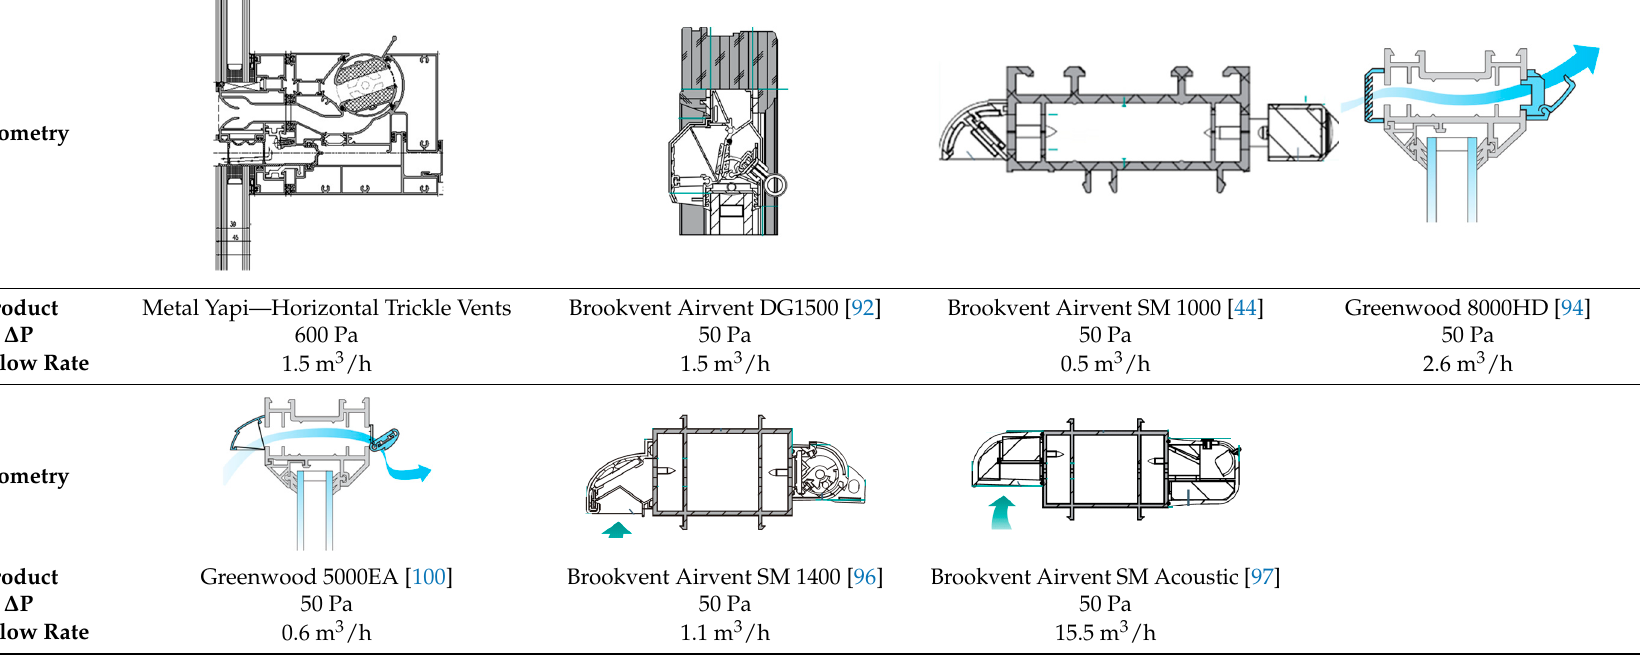
Table 12. Δ P and water spraying duration [59].